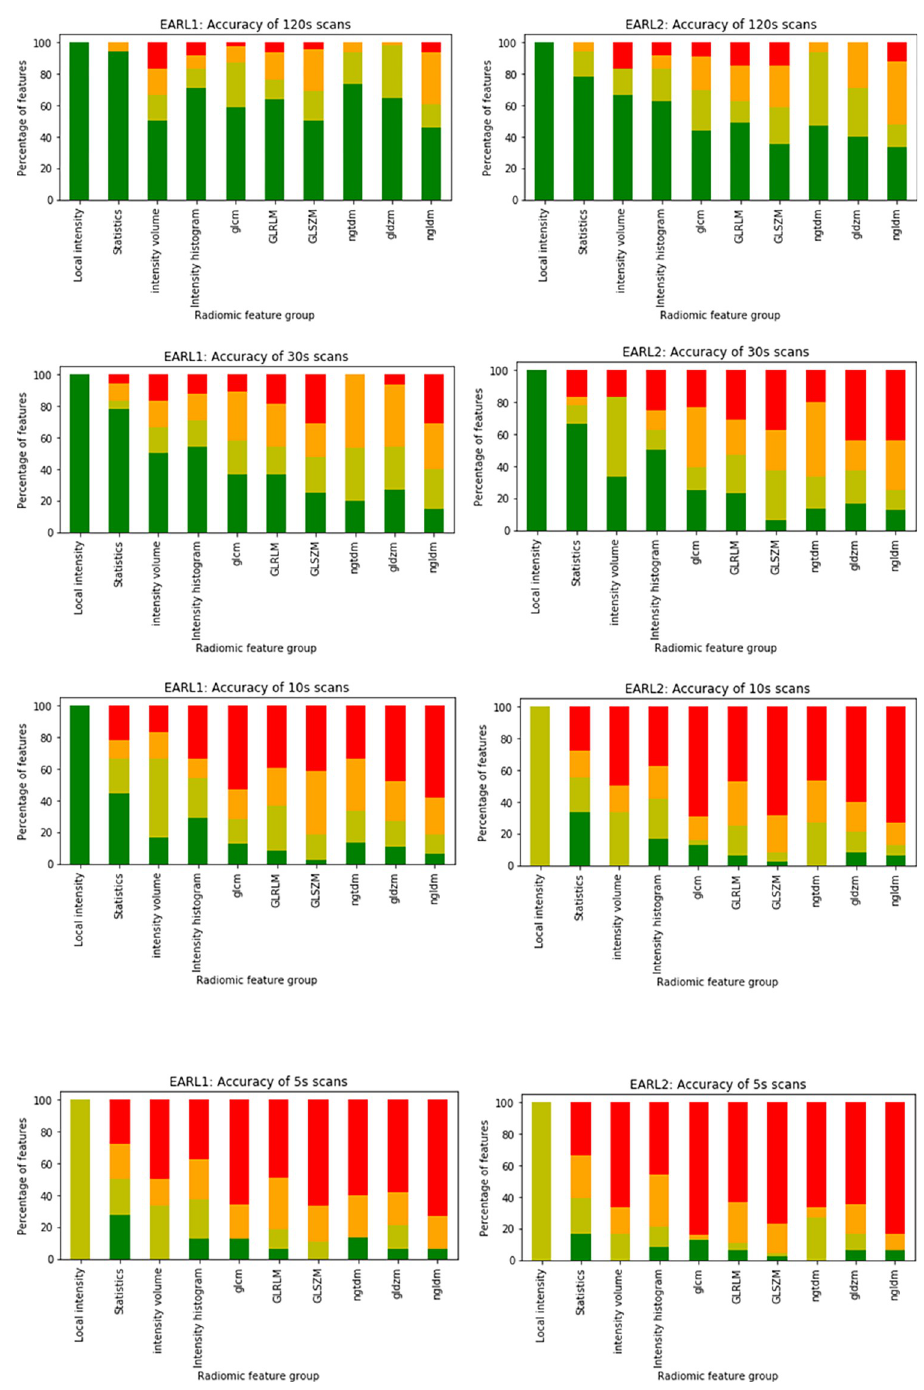
Fig 4. Percentage of features in each SDM category (dark green: Excellent SDM, light green: Good SDM, orange: Moderate SDM, red: Poor SDM) per feature group for different scan durations (from top to bottom: 120 s, 30 s, 10 s, 5 s) for EARL1 (left) and EARL2 (right) reconstructed